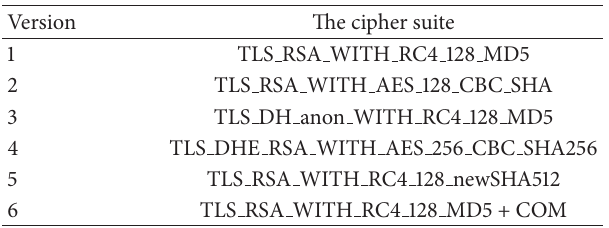
Table 7: The analysed versions of TLS protocol. Version The cipher